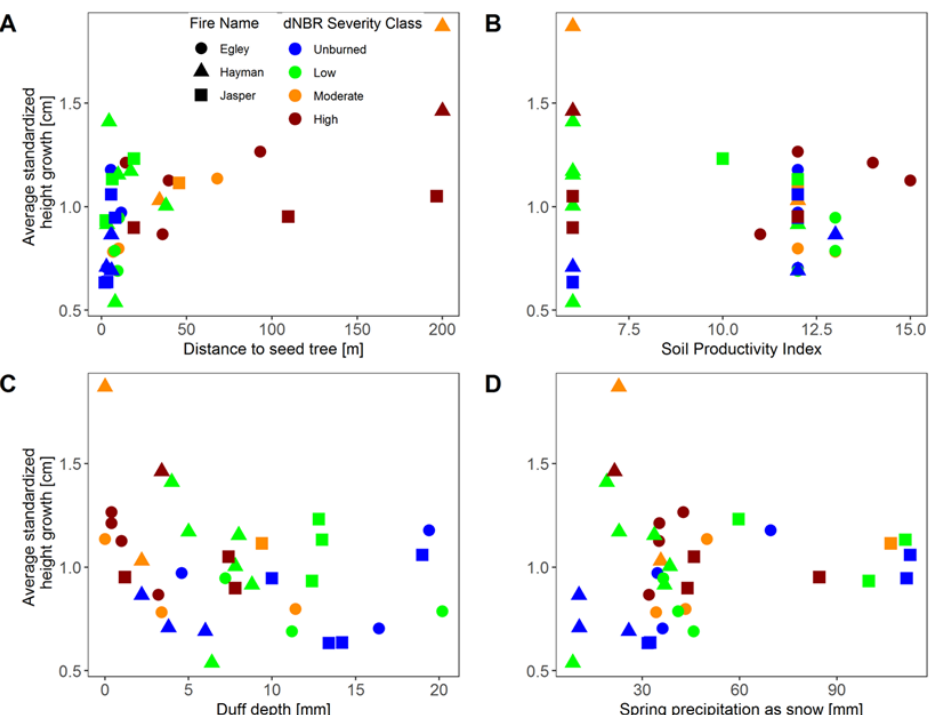
Figure 4. Predictors from best-fit non-parametric multiplicative regression (NPMR) model (see Table 2) for average height growth of ponderosa pine seedlings across a burn severity gradient following three large wildfires. Predictor variables are ( A ) distance to seed tree, ( B ) soil Productivity Index, ( C ) duff depth, and ( D ) spring precipitation as snow.